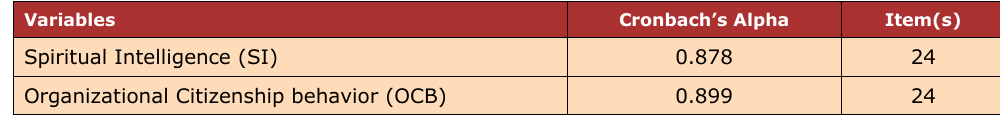
Table 2. Reliability Test Results